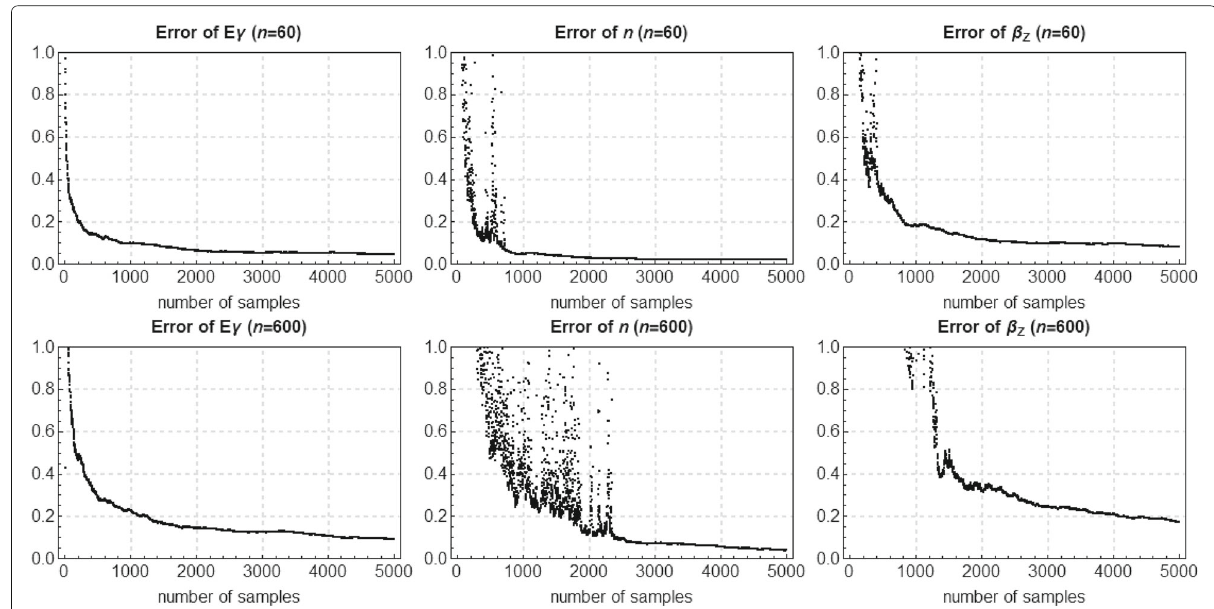
Fig. 4 Mean relative errors of estimates of E (γ) (left), n (middle) and β Z (right), computed by (3) from hundred series of simulated observations. In each series, the estimates are calculated in an incremental fashion by increasing the sample size (given on the horizontal axis). The true parameter values were E (γ) = 0.7, Var (γ) = 1 / 300, β X = 2 / 6, β Y = 1 / 6, β Z = 3 / 6, and n = 60 in the upper row and n = 600 in the lower